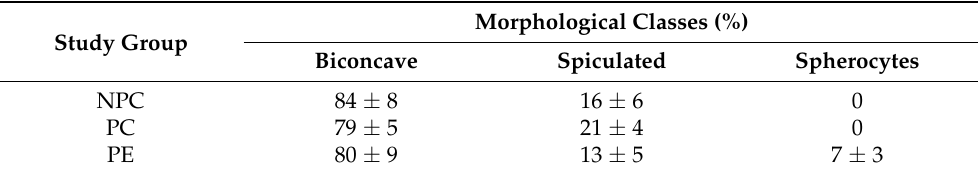
Table 2. Percentage of RBC morphological classes determined by optical microscopy of freshly iso- lated cells from non-pregnant controls (NPCs), pregnant controls (PCs), and patients with preeclamp- sia (PE). Mean ± SD. Morphological Classes (%) Study Group Biconcave Spiculated Spherocytes NPC 84 ± 8 16 ± 6 0 PC 79 ± 5 21 ± 4 0 PE 80 ± 9 13 ± 5 7 ± 3